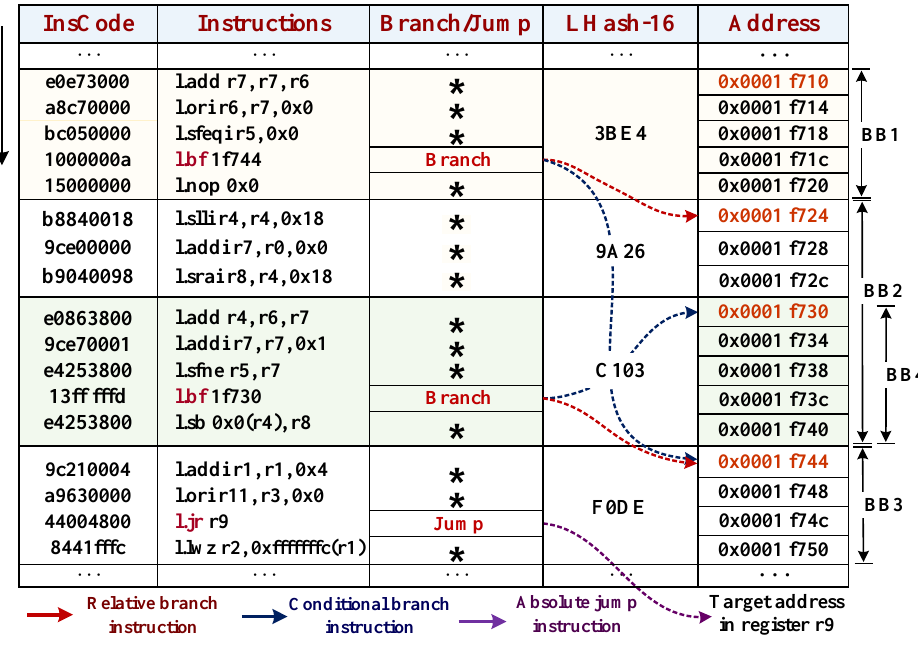
Figure 2. Example of partitioning the benchmark of OpenECC into program basic